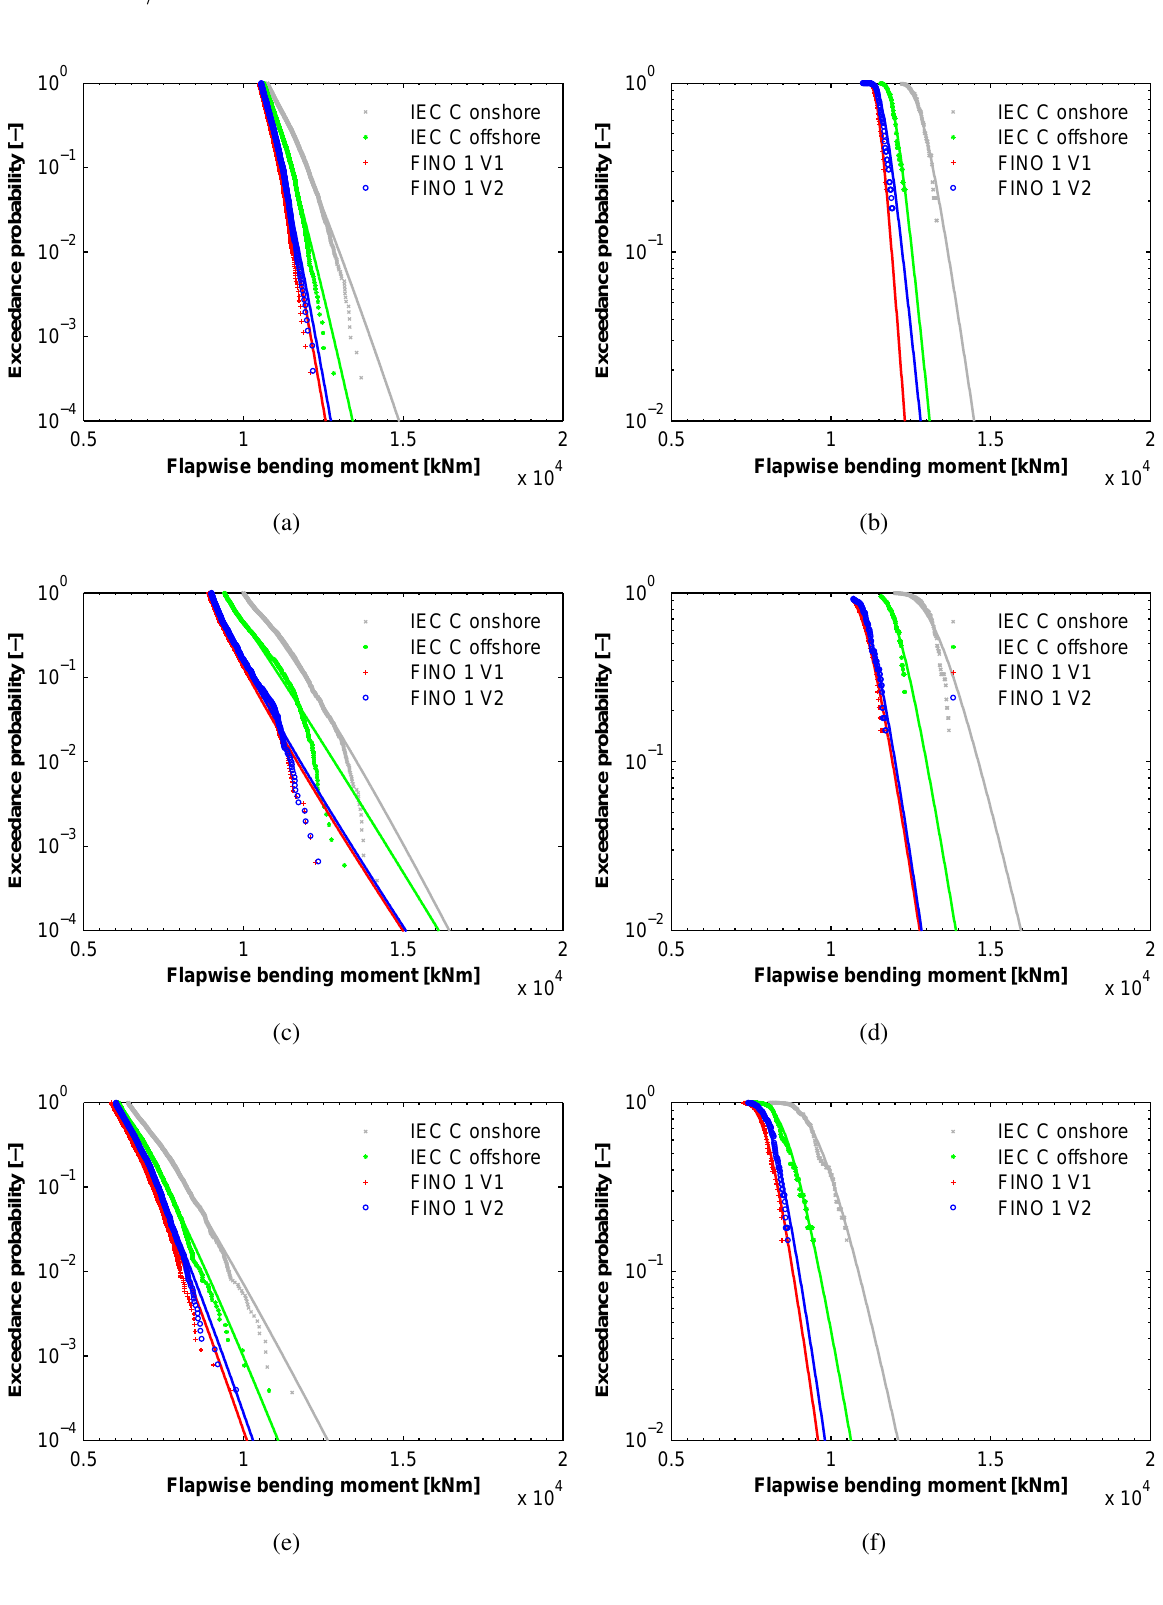
Figure 9. Local exceedance probability distribution for the flapwise bending moment at the blade root (please notice the different scales of the y-axis). ( a ) POT, v = 11 m/s ; ( b ) ACER, v = 11 m/s ; ( c ) POT, v = 13 m/s ; ( d ) ACER, v = 13 m/s ; ( e ) POT, v = 21 m/s ; ( f ) ACER, v = 21 m/s